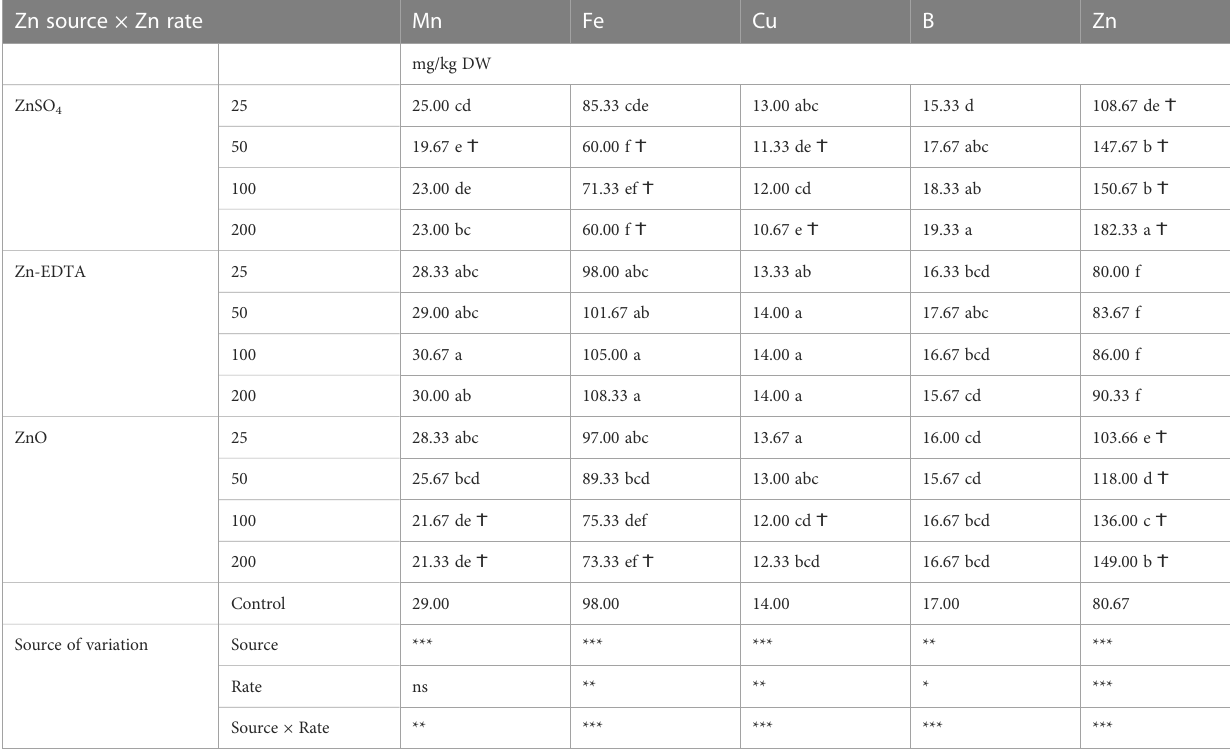
TABLE 4 Effects of seed soaking with different Zn sources and rate on the micromineral pro fi le of pea microgreens.